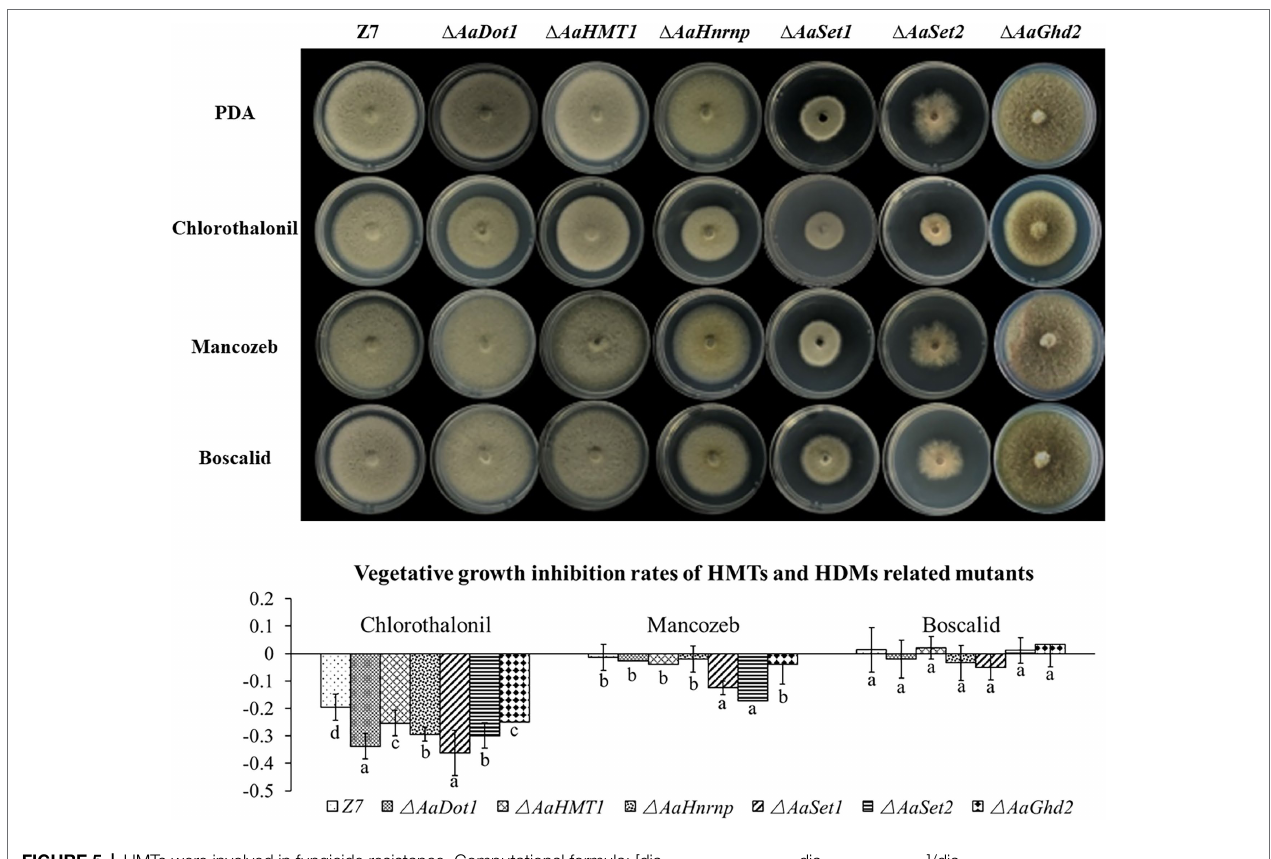
FIGURE 5 | HMTs were involved in fungicide resistance. Computational formula: [dia. (Z7 or mutant under stress) − dia. (Z7 or mutant in PDA) ]/dia. (Z7 or mutant in PDA)